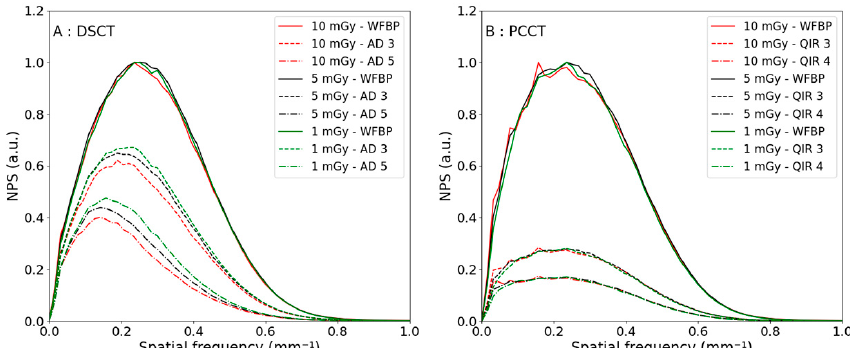
Figure 5. Noise power spectra curves in the case of virtual monoenergetic reconstruction, with a CTDI vol of 10 mGy in red, 5 mGy in black and 1 mGy in green, when increasing the iteration level of the reconstruction algorithm for the DSCT ( A ) and the PCCT ( B ). WFBP—weighted fi ltered back projection and AD—ADMIRE.